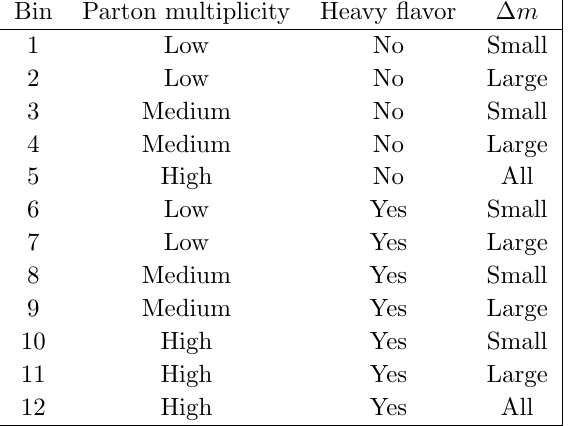
Table 8 . Targeted event topologies for the 12 aggregate search bins. The variable (cid:1) m states the di(cid:11)erence between the gluino or squark mass and the sum of the masses of the particles into which the gluino or squark decays.